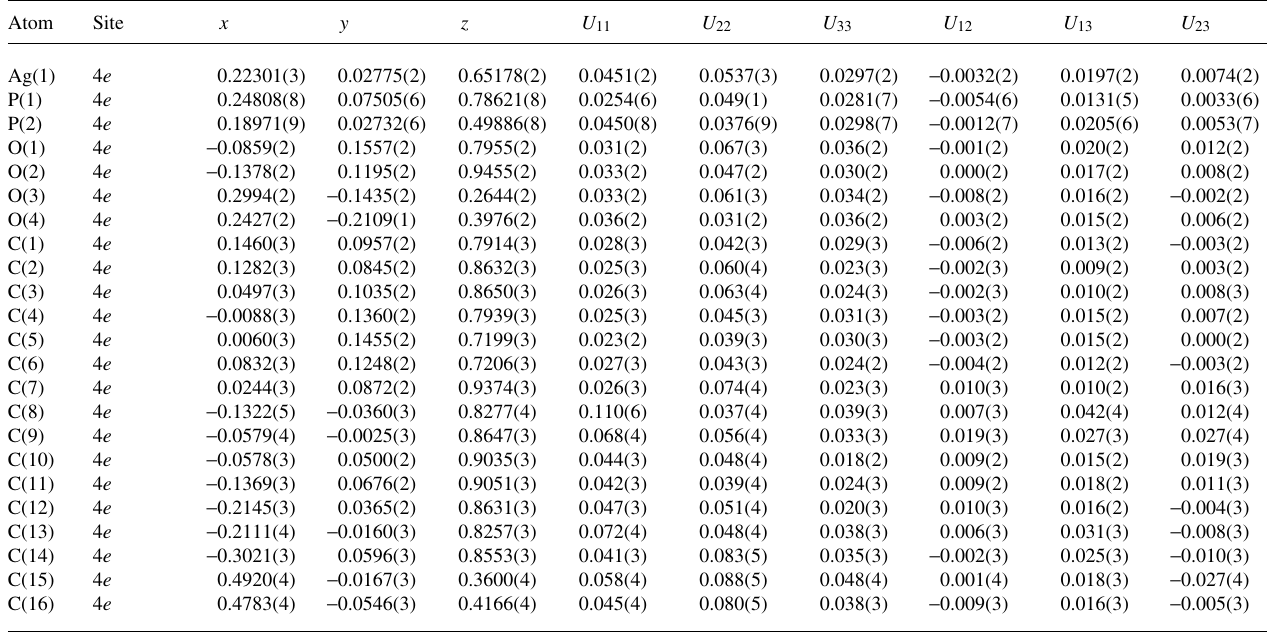
Table 3. Atomic coordinates and displacement parameters (in Å 2 ) .